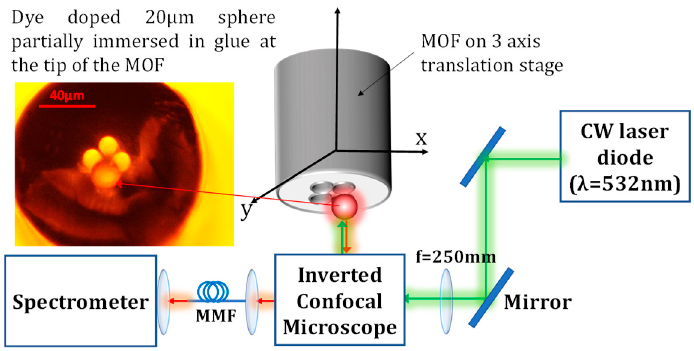
Figure 1. Schematic diagram of the experimental setup. MMF: Multi-mode fiber.